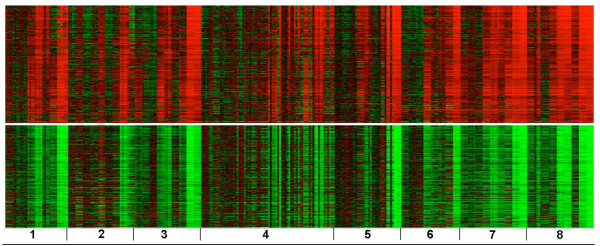
Heat maps of two biclusters containing all samples and genes unconstrained by ALT. (A) 330 co-expressed genes are up-regulated in the top half; (B) 409 co-expressed genes are down-regulated in the bottom half. The samples are ordered the same as in Figure 1.